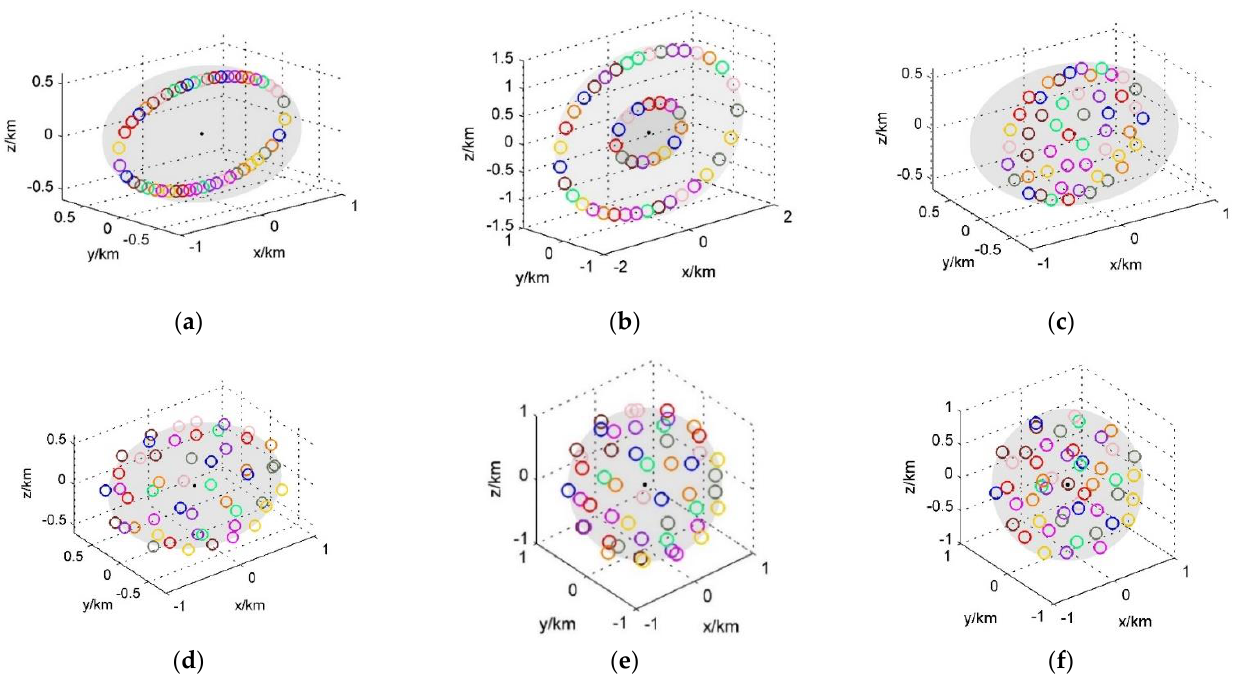
Figure 19. A variety of satellite cluster formations. ( a ) Ellipse ( a = 1, b = 0.6, r = 1 km, µ = − 5 km);